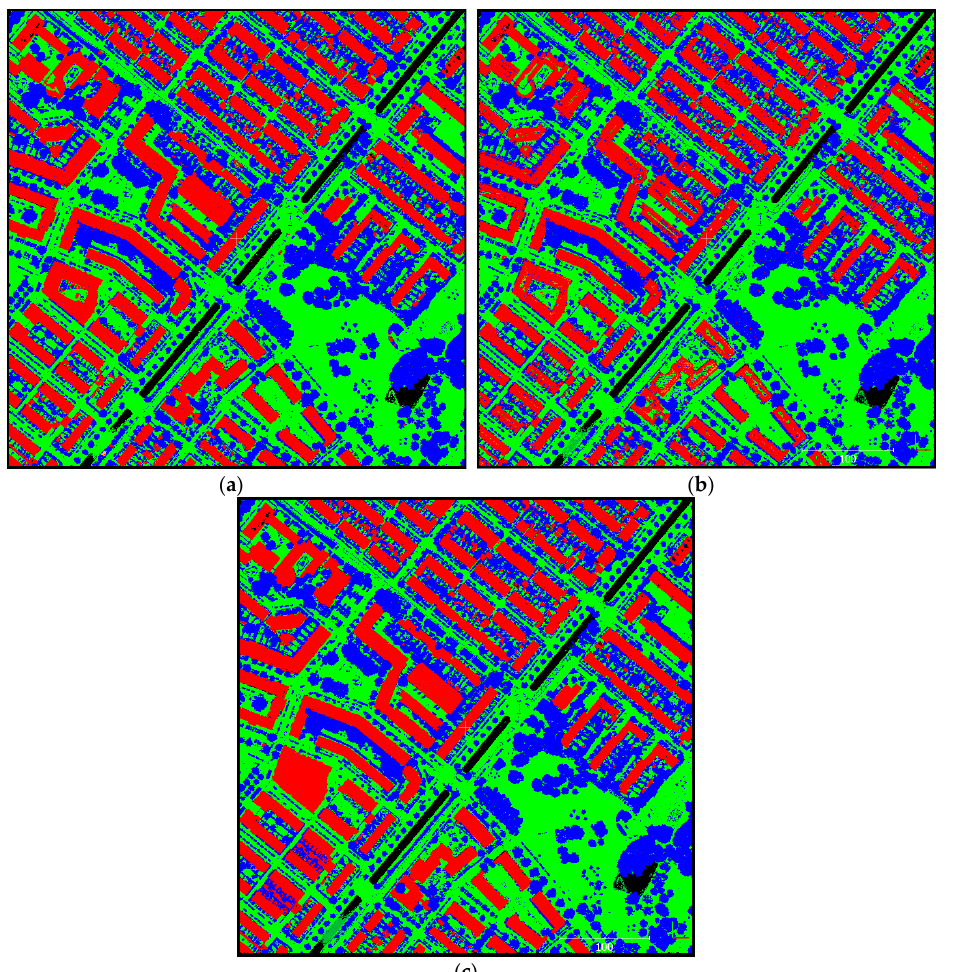
Figure 16. Multi-class classification results on sample TS7 of the AHN3 dataset: ( a ) MTN-FCN; ( b ) Random Forest (RF); ( c ) Reference. Green: ground; blue: vegetation; red: building; dark green: water.